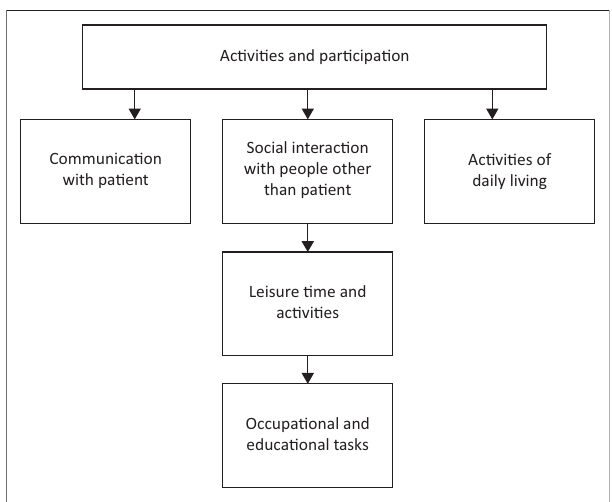
FIGURE 2: Sub-themes identified under activities and